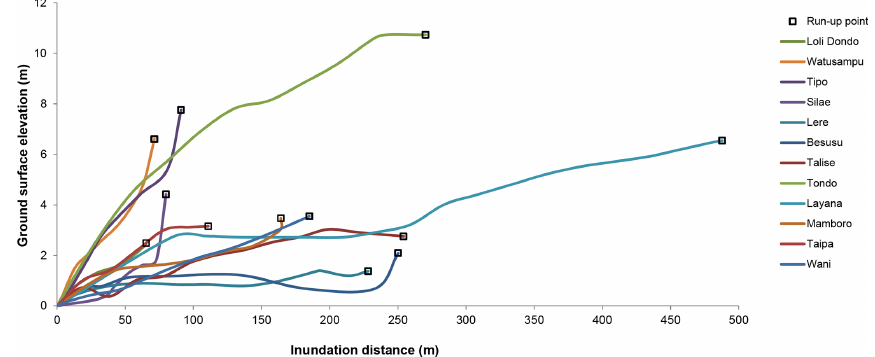
Figure 5. Transects of beach where tsunami wave arrived. The longest inundation distance is at the Layana site and the highest run-up is at the Tondo site.